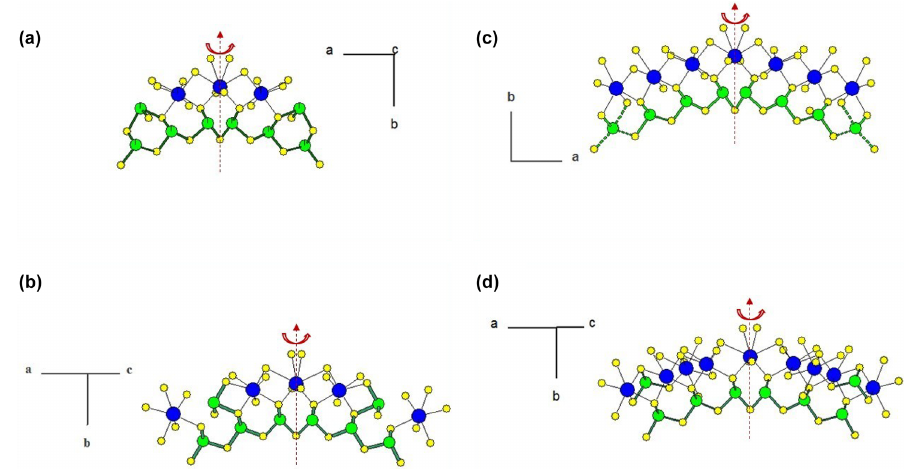
Figure 3. Polymerization of SbS 3 polyhedra in the plagionite series: (a) fülöppite (Sb 8 S 15 ) , (b) plagionite (Sb 8 S 17 ) , (c) heteromorphite (Sb 8 S 19 ; Edenharter, 1980), and (d) semseyite (Sb 8 S 13 and two isolated Sb 2 S 3 ) . Red: 2-fold